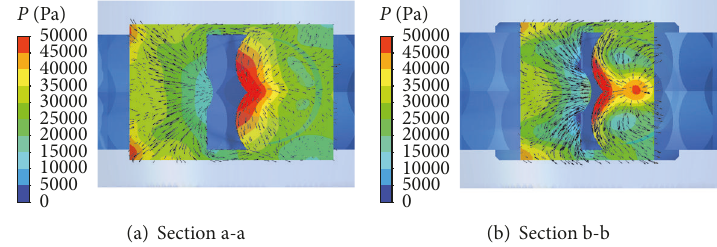
Figure 29: Static pressure distributions and absolute velocity vectors of Blade A ( 𝜃 ∗ = 48 ∘ , 𝑛 = 400 ,000 min −1 ).